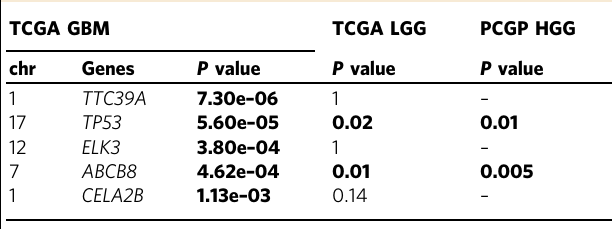
chr chromosome, FDR false discovery rate, GBM glioblastoma multiforme, HGG high-grade glioma, LGG low-grade glioma, PCGP Pediatric Cancer Genome Project, TCGA The Cancer Genome Atlas. P values less than 0.05 are in